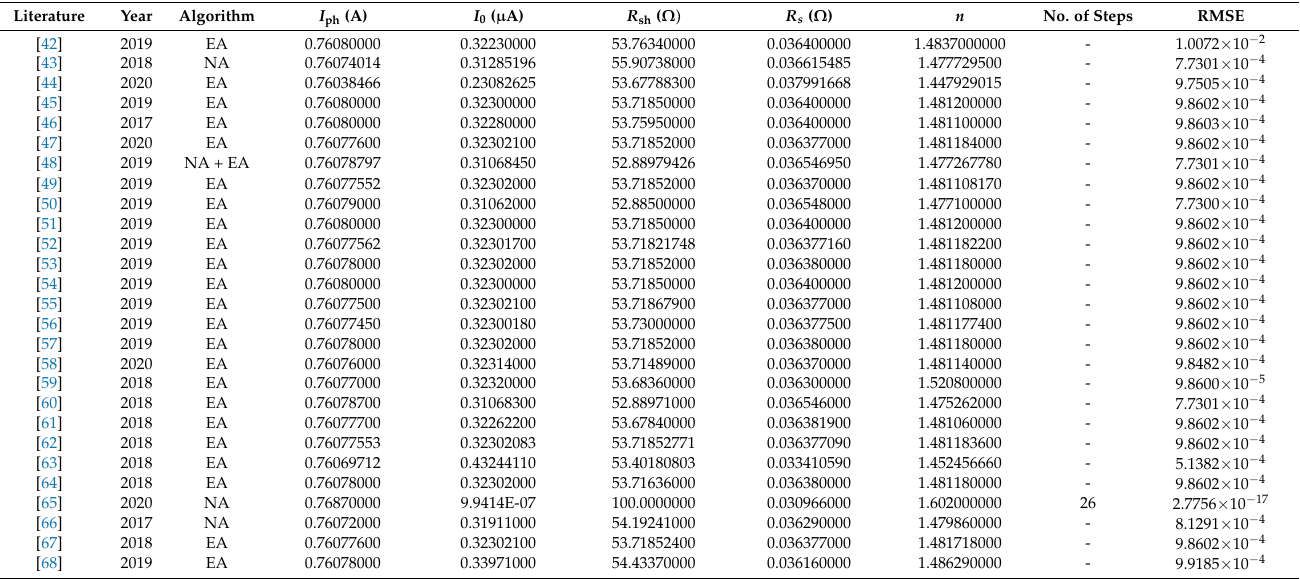
Table 1. Comparison of the parameters obtained in Case Study 1.